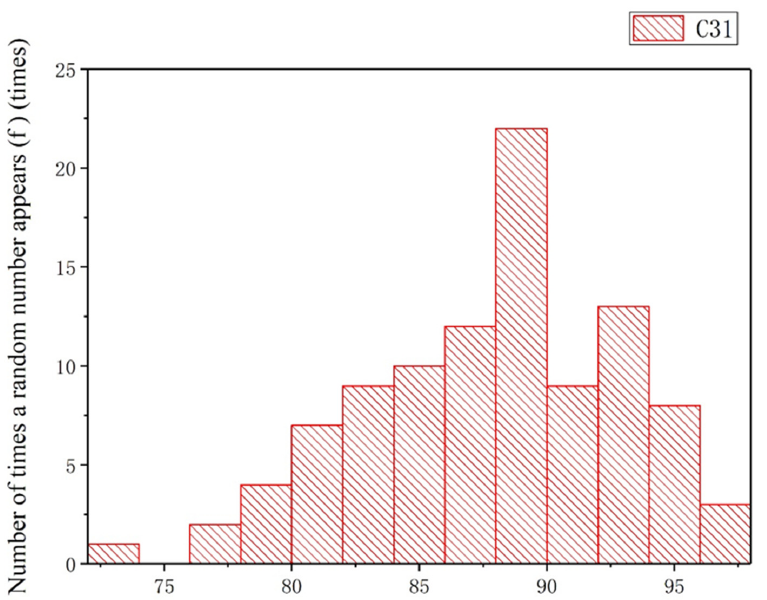
Figure 6. Probability distribution histogram of a random number.